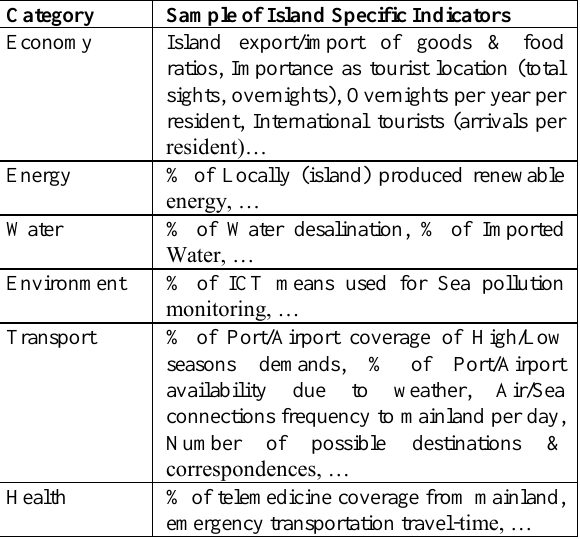
Table 2. Sample of island-specific indicators added to the typical city KPIs by the proposed S 2 I 2 .